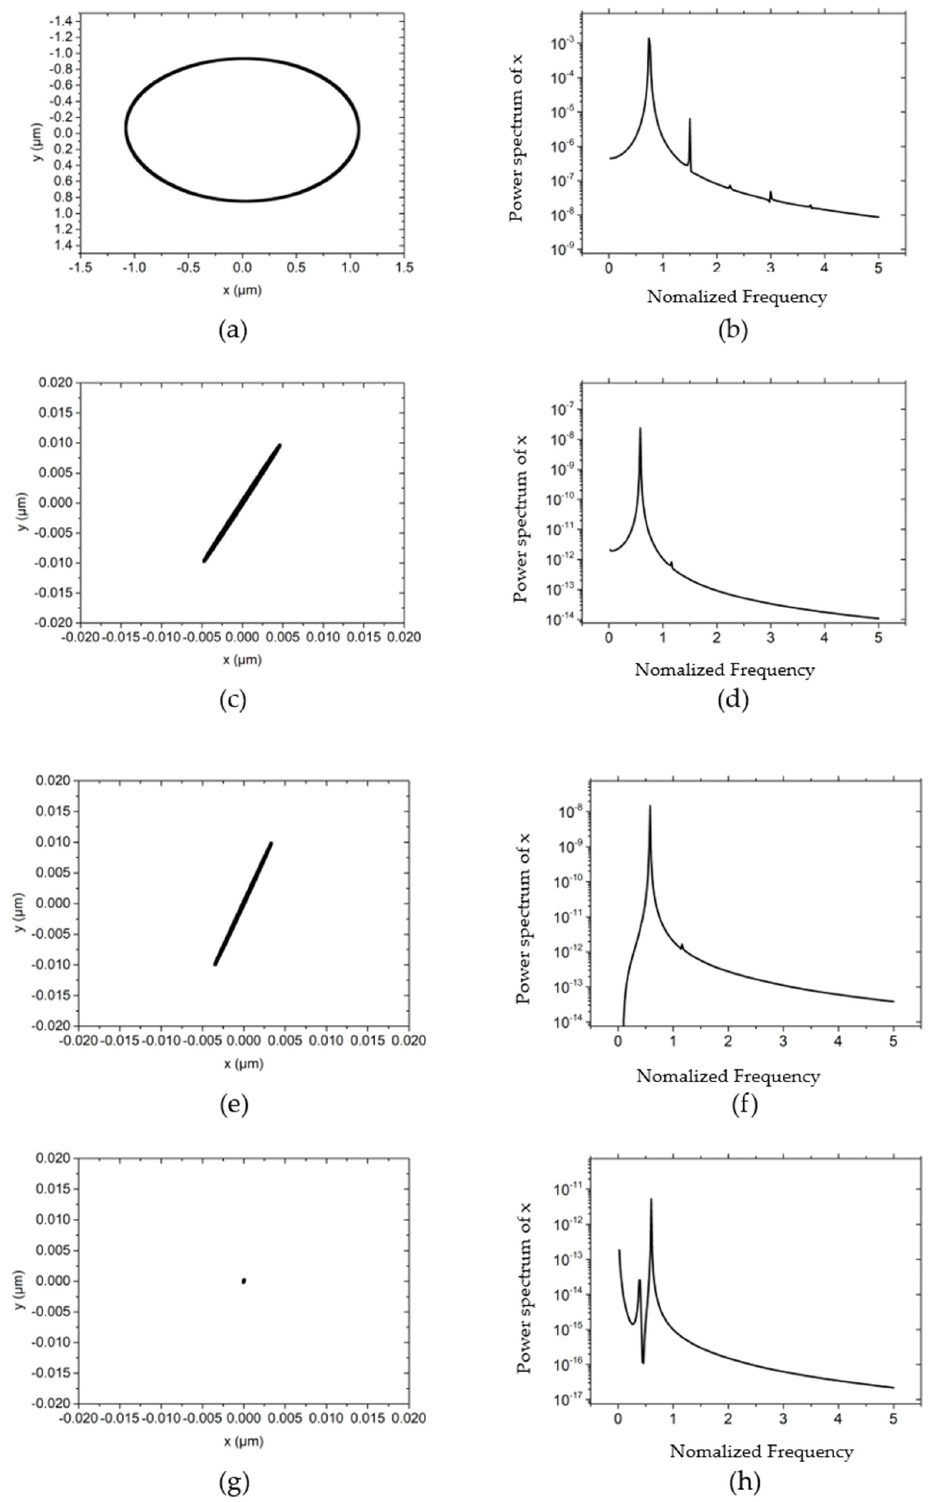
Figure 4. The influence of different rotor mass on rotor trajectory and power spectral density w = 50,000 r/min, Fy = 10 N, m u = 0.01 g. ( a ) Rotor center trajectory ( m = 50 g), ( b ) Power spectral density in the x direction ( m = 50 g), ( c ) Rotor center trajectory ( m = 90 g), ( d ) Power spectral density in the x direction ( m = 90 g), ( e ) Rotor center trajectory ( m = 120 g), ( f ) Power spectral density in the x direction ( m = 120 g), ( g ) Rotor center trajectory ( m = 150 g), ( h ) Power spectral density in the x direction ( m = 150